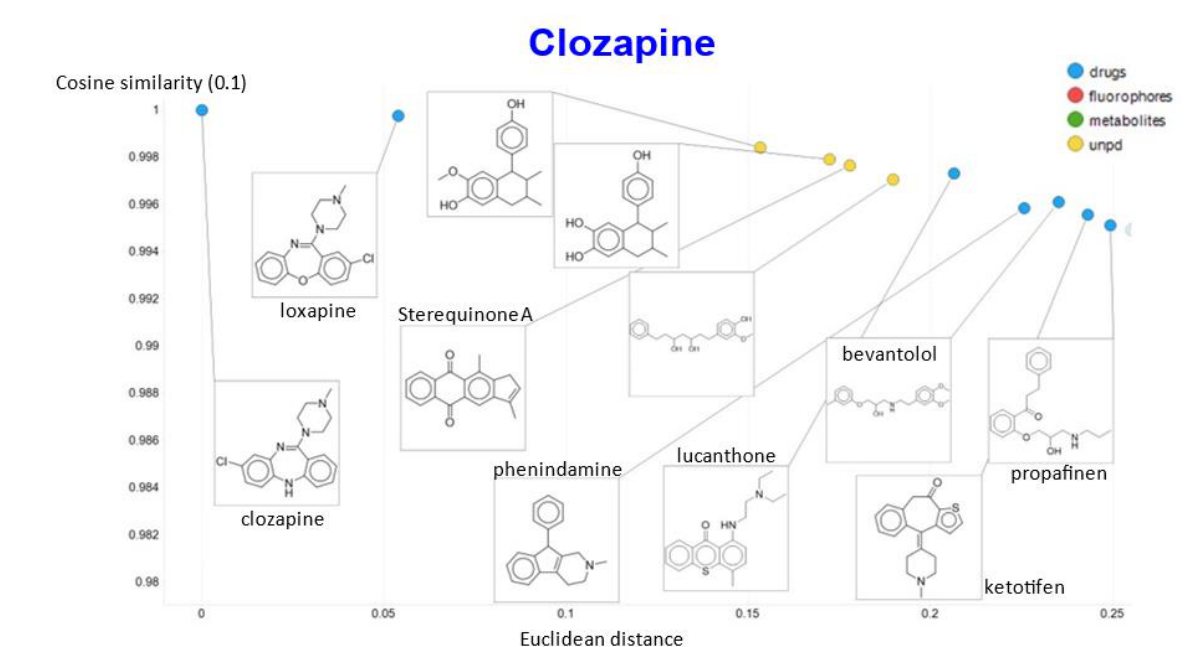
Figure 19. Molecules closest to clozapine when a temperature of 0.1 is used, as judged by both cosine similarity and Euclidean distance.